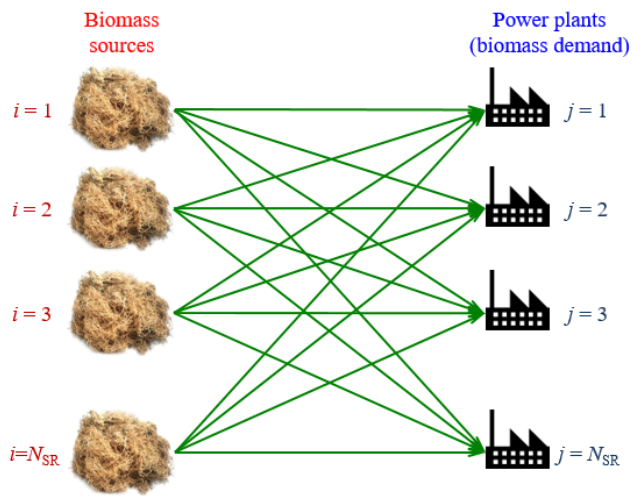
Figure 1. Superstructure representation of biomass source-demand model (adapted with permission from [16]).